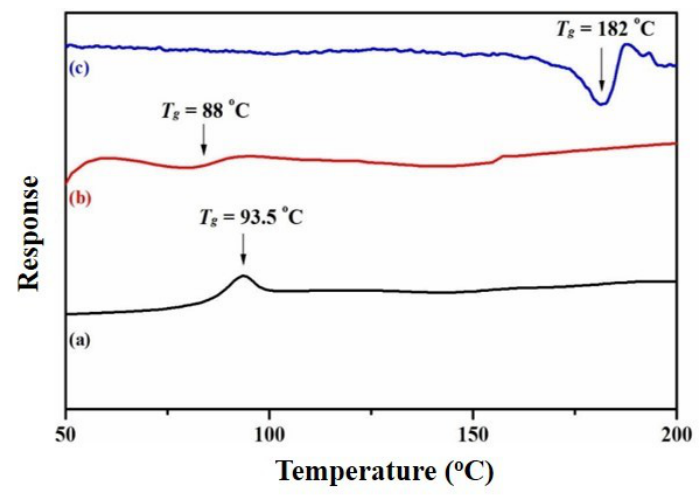
Figure 8. DSC thermograms for ( a ) neat PS-PMMA, ( b ) RGO / AgNPs-(PS-PMMA), and ( c ) R-(GO-(PS- PMMA))-AgNPs.